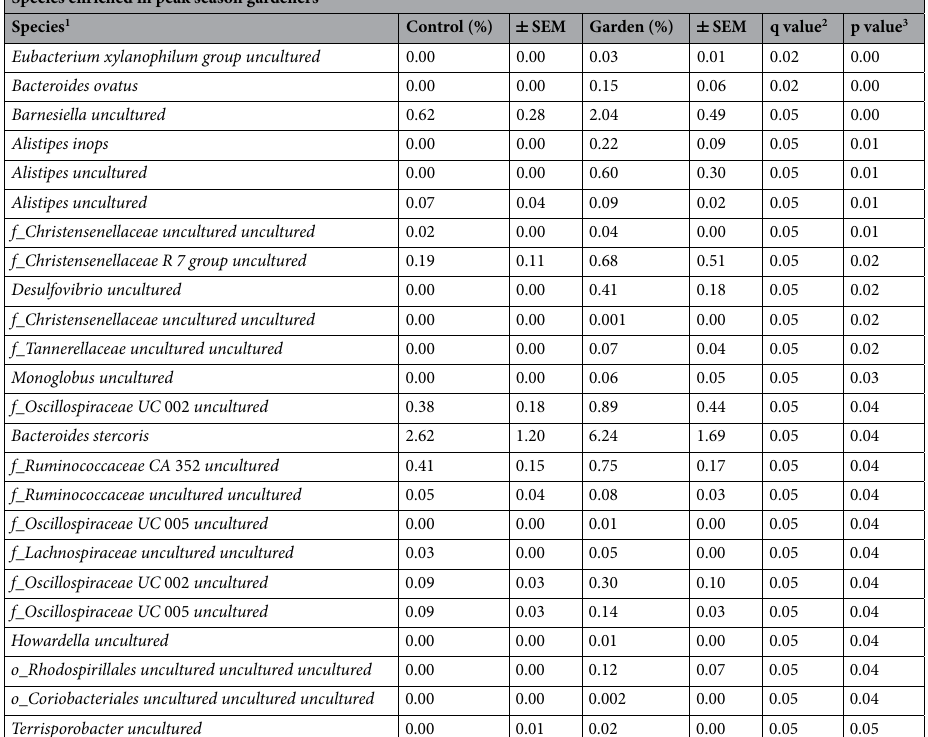
Table 2. Significance of species greatest in gardeners at peak season when compared to peak season control. 1 Average relative abundances (%) of significant species ± SEM. 2 False Discovery Rate was used for adjustment. 3 Wilcoxon Rank Sum Test.